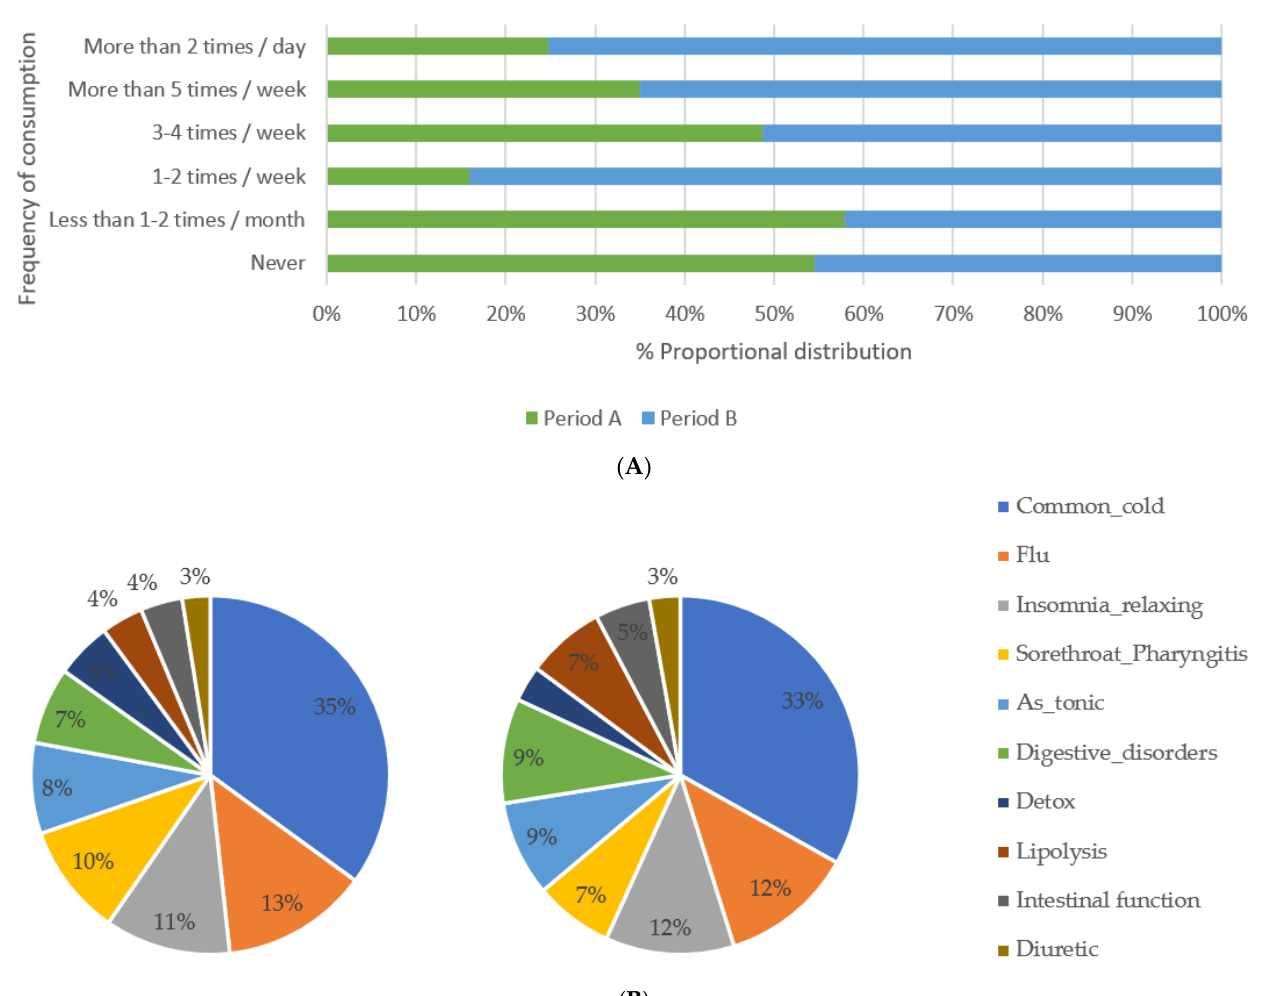
Figure 3. ( A ) MAPs frequency of consumption during Period A (before COVID-19) and Period B (after COVID-19) ( B ) MAPs common cause of consumption during Period A and Period B.